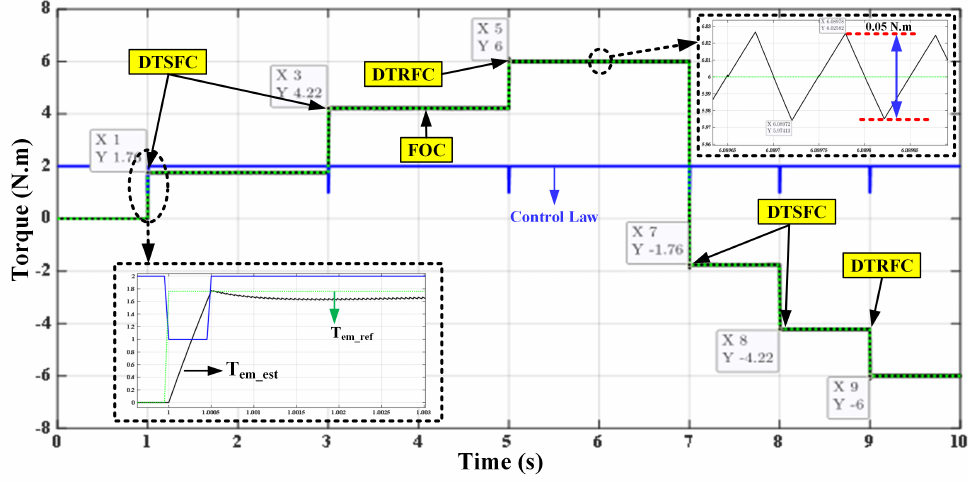
Figure 30. Torque response in the proposed combined FOC-DTC over a wide torque range.